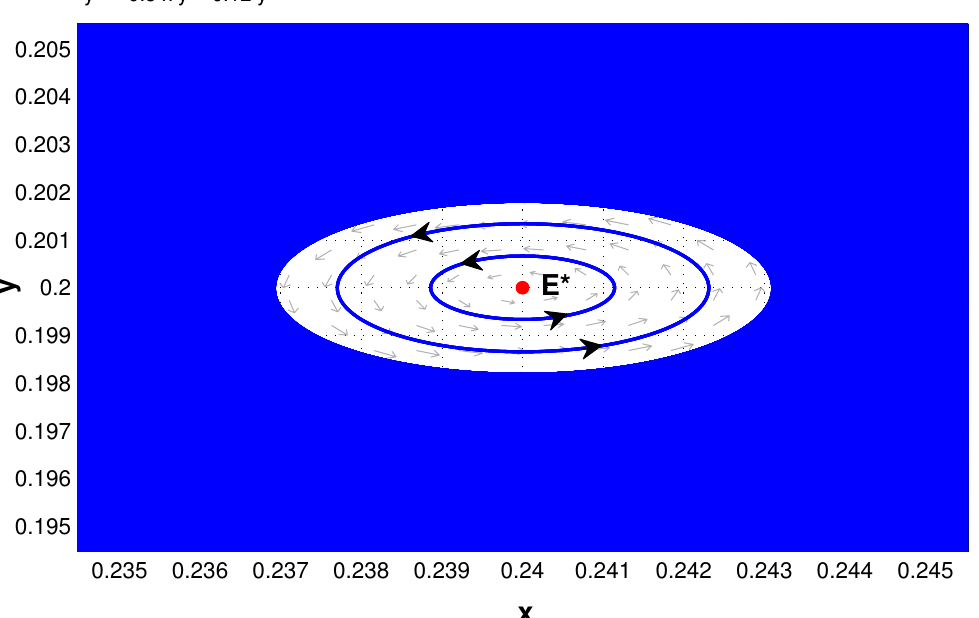
Figure 4. When a = a H = 0.26, a stable periodic orbit bifurcated form E ∗ which is locally